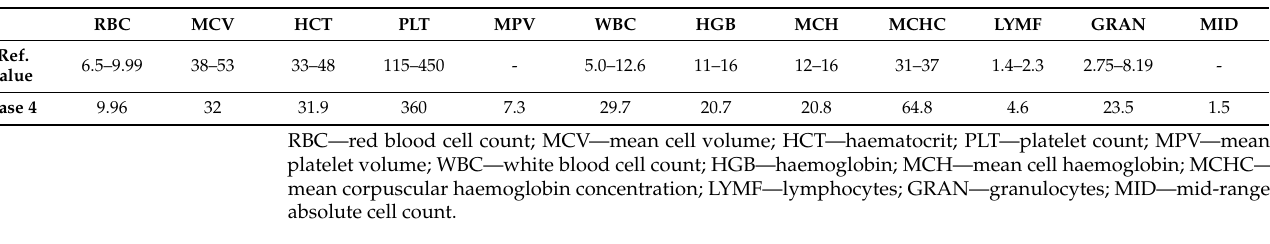
Table 2. Haematological results of Case 4 from the day of pyrexia onset with reference values